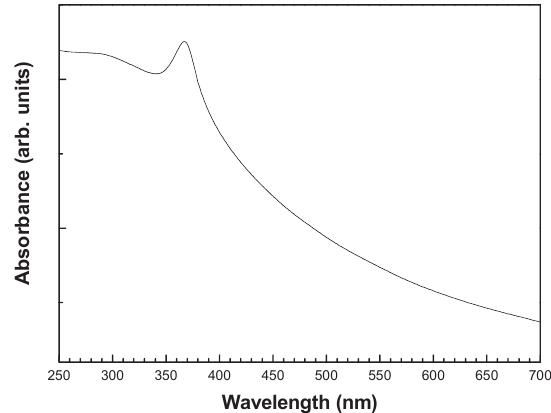
Fig. 4 Room-temperature UV-Vis optical absorbance spectrum of the nanocrystalline ZnO